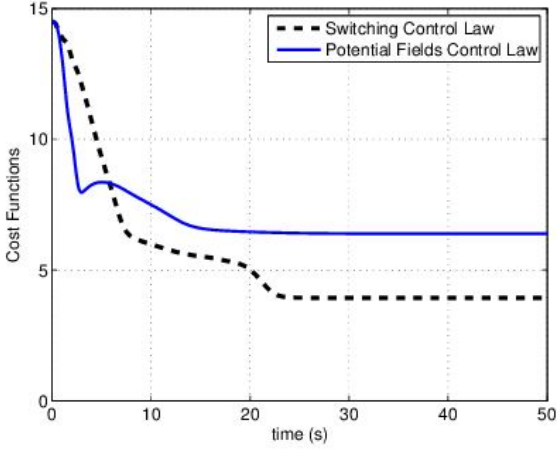
Figure 7. Cost function comparison (Example